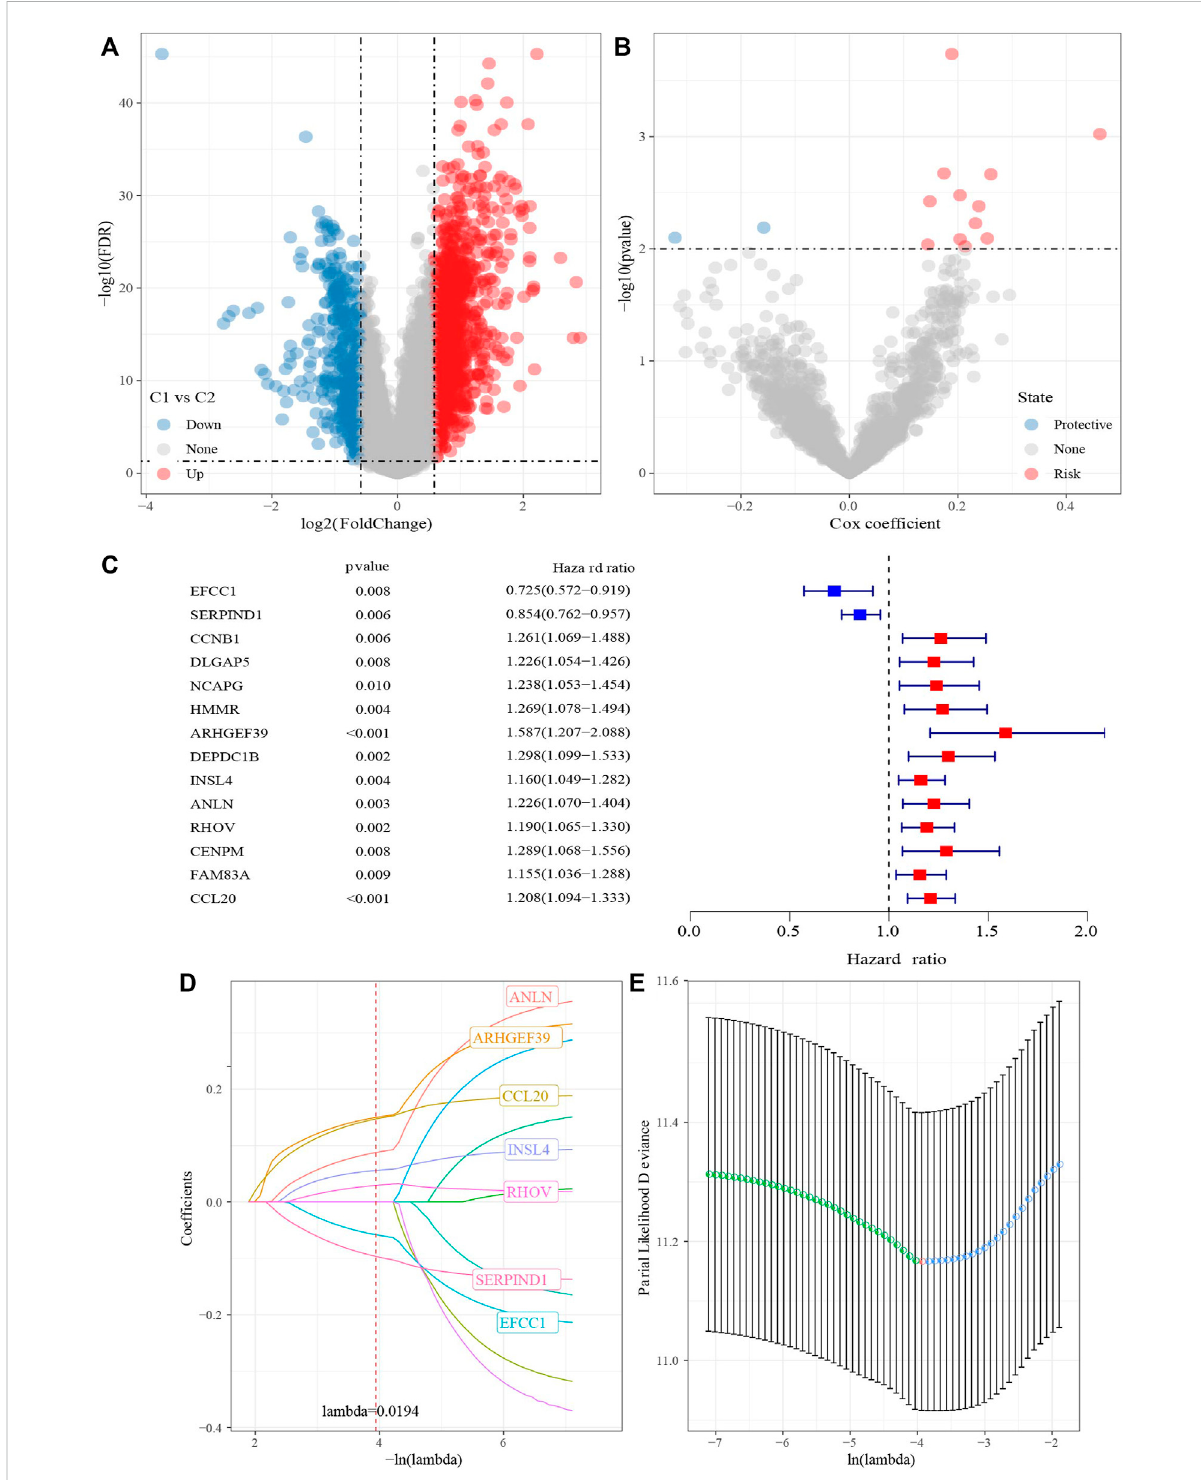
FIGURE 7 Identi fi cation hub cuproptosis related genes. (A) Volcano of differentially expressed genes identi fi ed from C1 and C2. (B) Volcano of differentiallyexpressed genesidenti fi edusingunivariateCoxanalysis. (C) Forestmapofdifferentiallyexpressed genesidenti fi edusingunivariateCox analysis. (D) Lambda trajectory of differentially expressed genes. (E) Con fi dence interval under